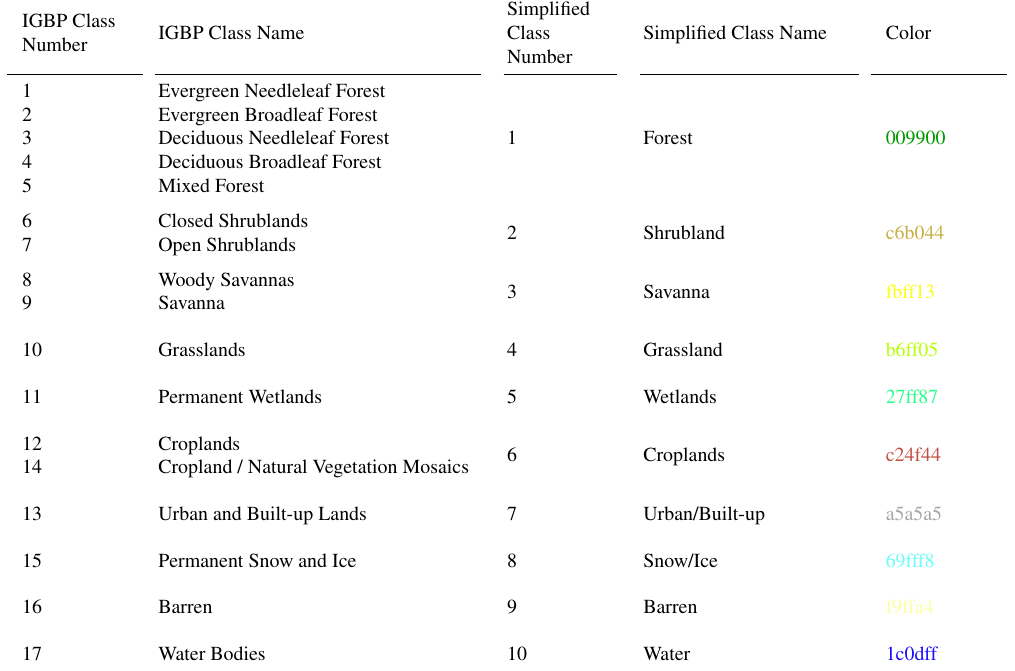
Table 1. The simplified IGBP land cover classification scheme.